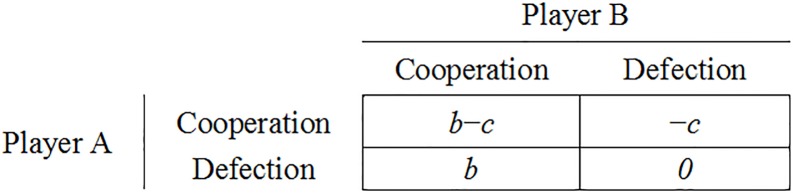
Payoff matrix of the “donation game”.The entries in the matrix refer to the payoffs of player A. The benefit of cooperation (b), the cost of cooperation (c), and b − c are greater than 0.